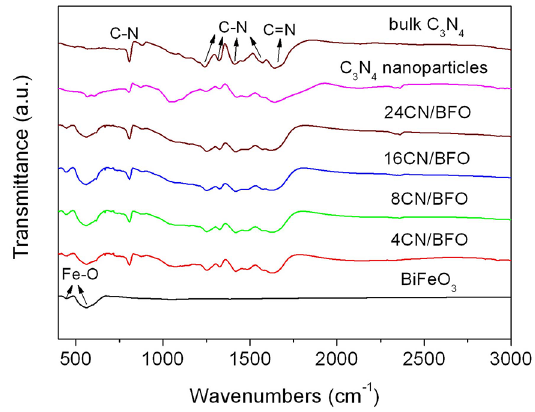
N , g-C N nanoparticles, 3 4 3 4